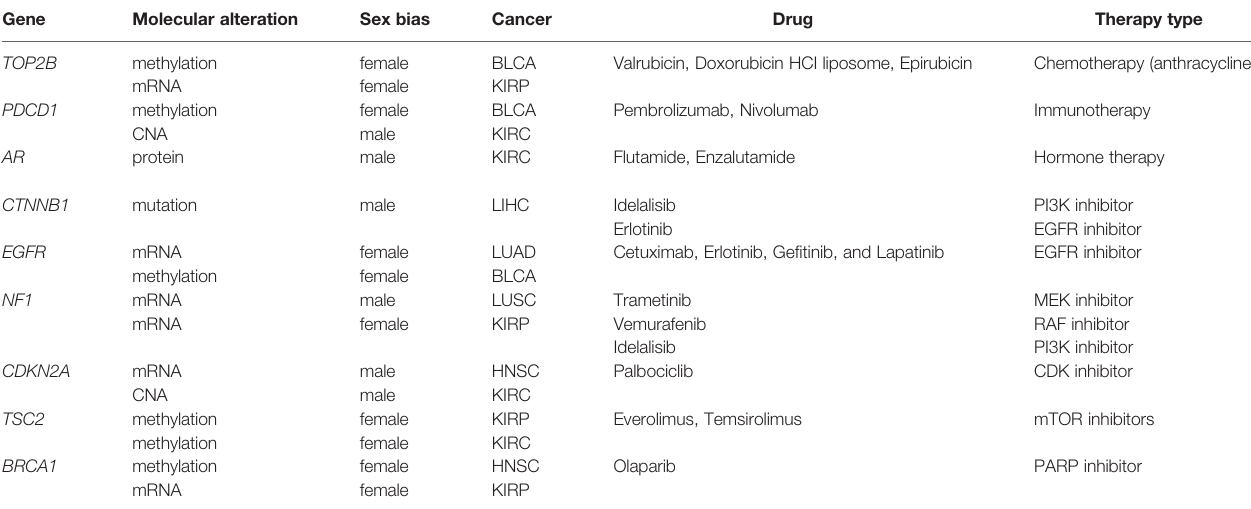
TABLE 1 | Examples of cancer drugs and their related-actionable genes, harboring sex-biased genomic